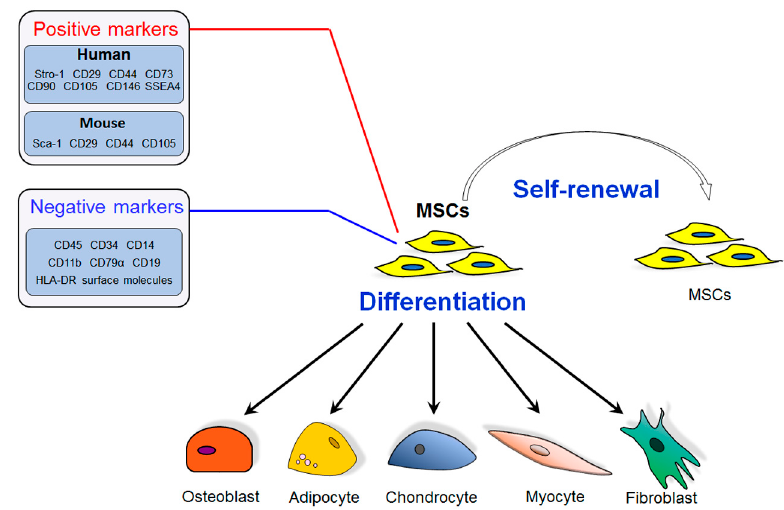
Figure 1. Schematic diagram of the characteristics of mesenchymal stem cells (MSCs). There are both positive markers and negative markers for identifying MSCs. MSCs possess the characteristics of self-renewing and differentiating into multiple cell types, including osteoblast, adipocyte, chondrocyte, myocyte, and fibroblast.